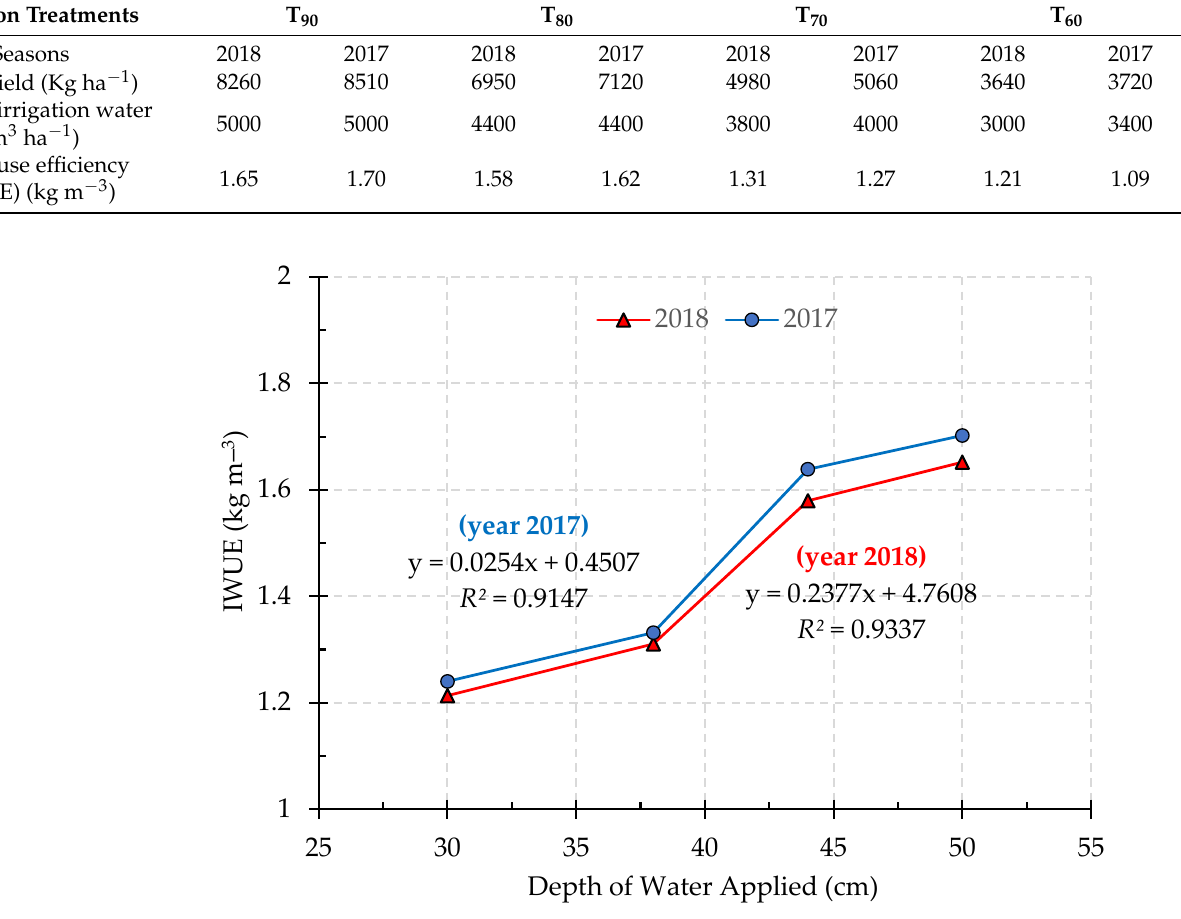
Figure 9. Relationship between water use efficiencies and applied depth of water (cm).